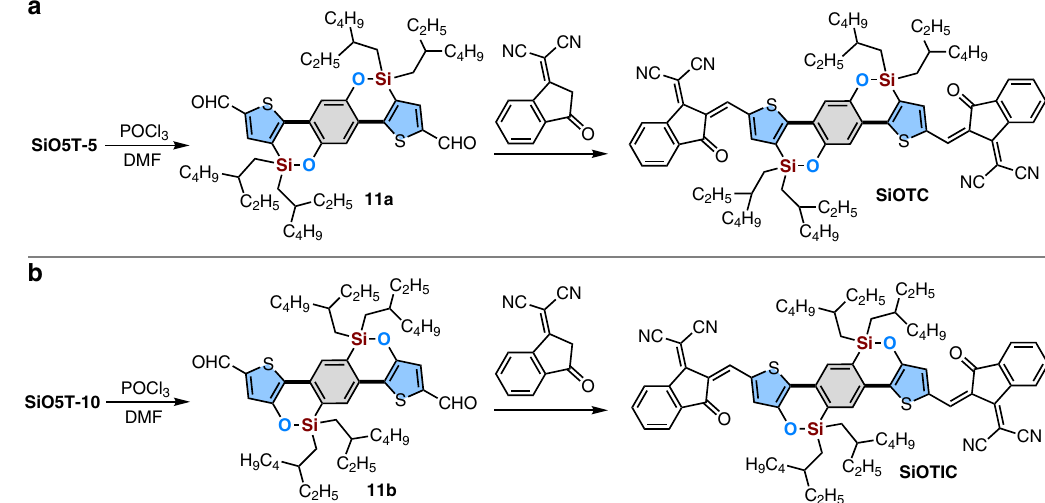
Fig. 3 Development of the two A-D-A nonfullerene acceptors based on ladder-type SiO-bridged π -systems. a The synthetic route for the acceptor SiOTC . b The synthetic route for the acceptor SiOTIC